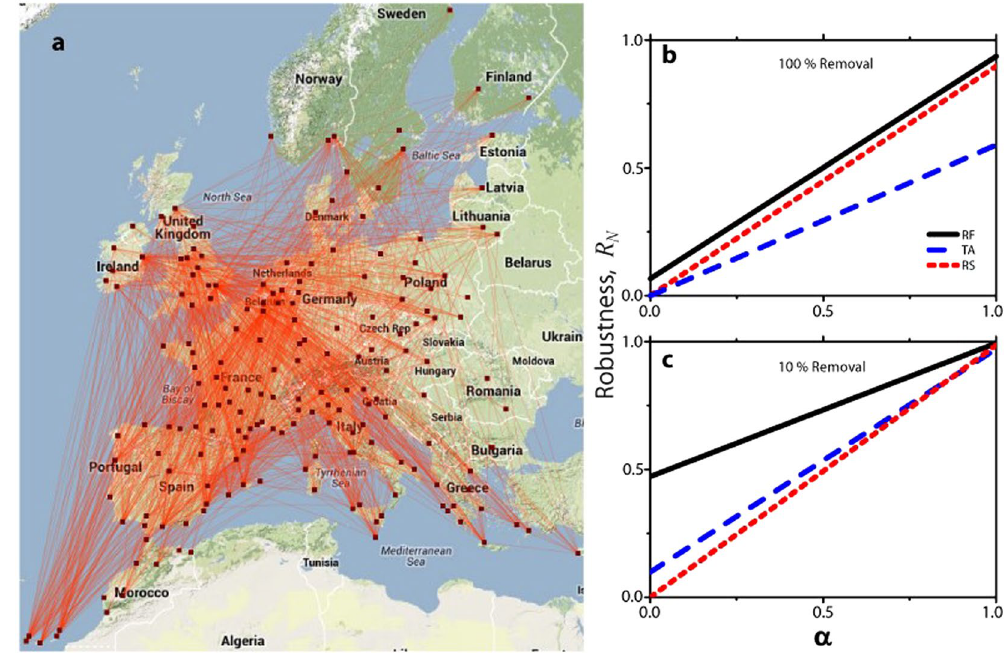
Figure 4. Robustness, R N , of the second largest airline network in Europe. ( a ) The map shows the connectivity of the second largest airline in Europe (RyanAir), operating in 186 airports (black squares), with more than 1500 routes (red lines). The map was generated using the Google Maps API and Map Data ©2014 Google . ( b ) shows the robustness of that network under three different attacks (Random Failure (RF), Targeted Attack (TA), and Random Spreading (RS)), which act until all the airports are removed. In panel ( c ), the robustness is evaluated under partial attack (10 % airports removed). Note that for α = 1, the network is equally robust under any of the three attacks. However, for α < 1 the robustness values for different attack strategies significantly differ, highlighting the importance of the Idle Network in assessing the robustness of the